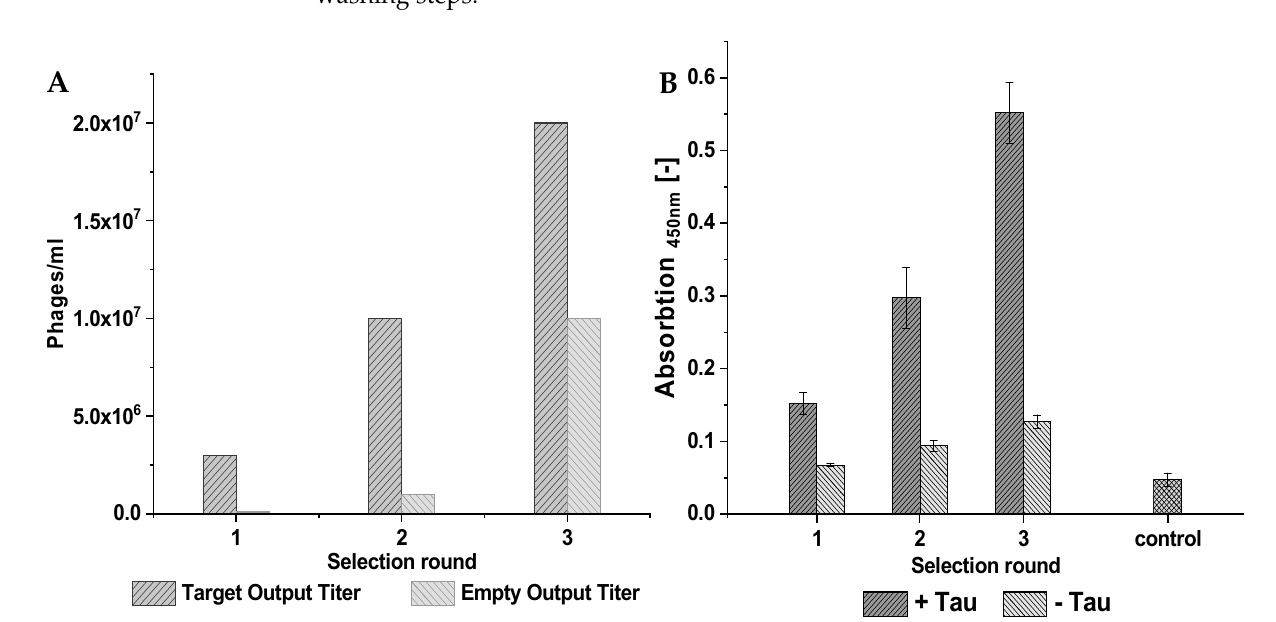
Figure 1. The selection progress was observed by following the output titer of target and empty selections as well as via enrichment ELISA. ( A ) For output titer determination, a phage dilution series was pipetted onto agar plates containing E.coli K12 . The phage titer of the target and empty selections increased with each selection round. Target selection, depicted in dark grey, contained the fragment of tau while the empty selection, shown in light grey, did not contain any tau. The increase in total phage count after each round proves the enrichment of phages over the course of the selection. ( B ) The plate for the enrichment ELISA was coated with 20 pmol of D-tau(271-316), shown in dark grey, and was incubated with 5 × 10 10 phages. Buffer was added instead of the D-tau(271-316) during coating to act as a negative control (light grey). Lastly, a separate control was performed to estimate the background noise level. This control did not contain any phages but was otherwise performed as the ELISA with D-tau(271-316). The signal intensity correlates with the amount of phages that are retained after several washing steps. We observed an increase in signal with higher selection rounds for wells that were coated with the D-tau(271-316), while the signal for the wells that were coated with buffer only showed a small increase. This indicates the enrichment of phages that are specific for the D-tau(271-316).